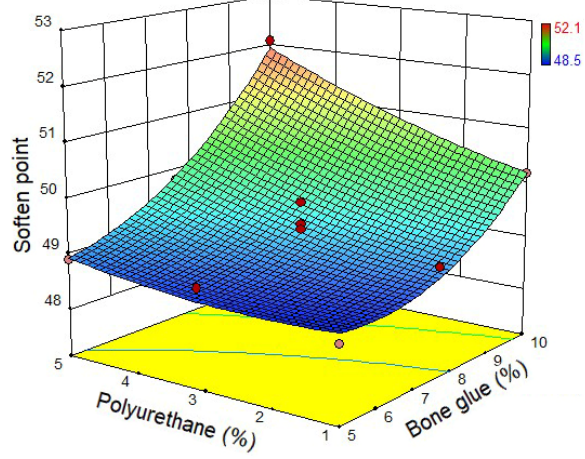
Figure 4. Penetration of the composite modified asphalt (CMA).